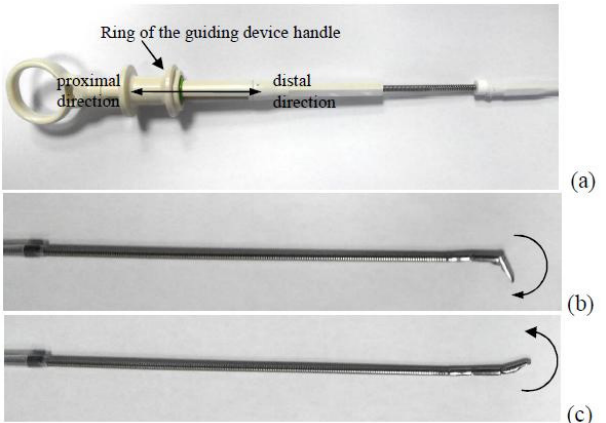
Figure 9. The concept of measuring the deflection of the guide based on the measurement of the displacement of the ring: ( a ) the guide holder ring; ( b ) the tip deflection corresponding to the proximal displacement of the ring; ( c ) the tip deflection corresponding to the distal displacement of the ring.